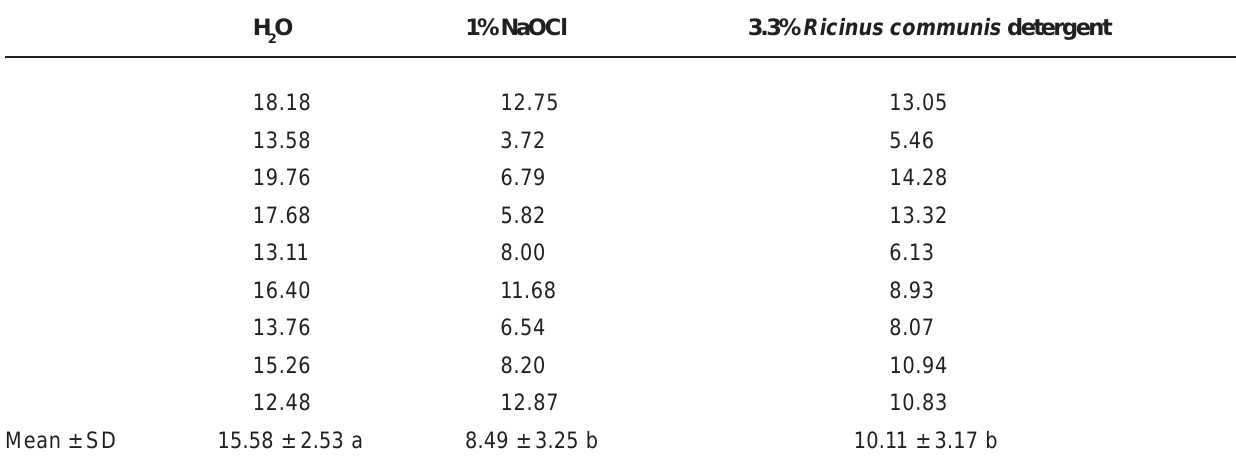
Tukey test (p<0.01): Critical value = 0.33. Different letters indicate statistically significant difference